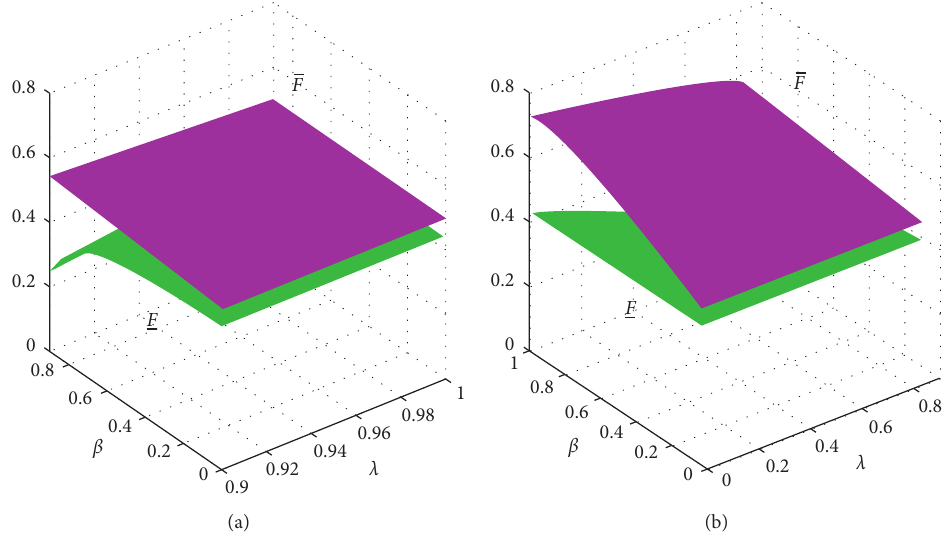
Figure 10: The change of F by λ and β . (a) λ ∈ (( 8/9 ) , 1 ) , β ∈ ( 0 , β